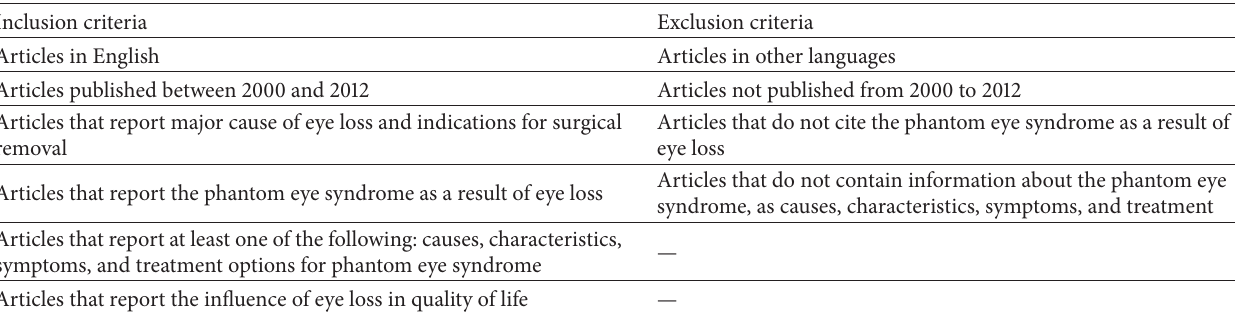
Table 1: Inclusion and exclusion criteria for selection of